Question: Write a descriptive caption for this figure.
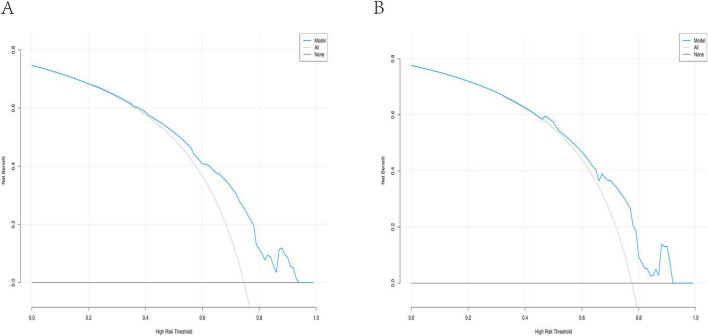
Answer: Decision curve evaluation of the nomogram model in the training cohorts (A) and validation cohorts (B) .